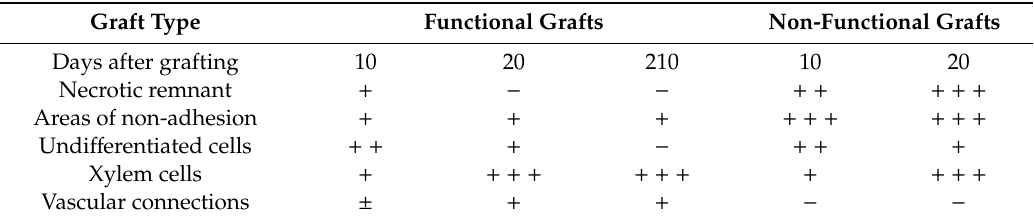
Table 1. Summary of histological characteristics corresponding to the graft junction of functional and non-functional homografts and heterografts in Solanum lycopersicum at 10, 20, and 210 days after grafting. No apparent di ff erences among homografts and heterografts were observed. Graft Type Functional Grafts Non-Functional Grafts Days after grafting 10 20 210 10 20 Necrotic remnant + − − + + + + + Areas of non-adhesion + + + + + + + + + Undi ff erentiated cells + + + − + + + Xylem cells + + + + + + + + + + + Vascular connections ± +